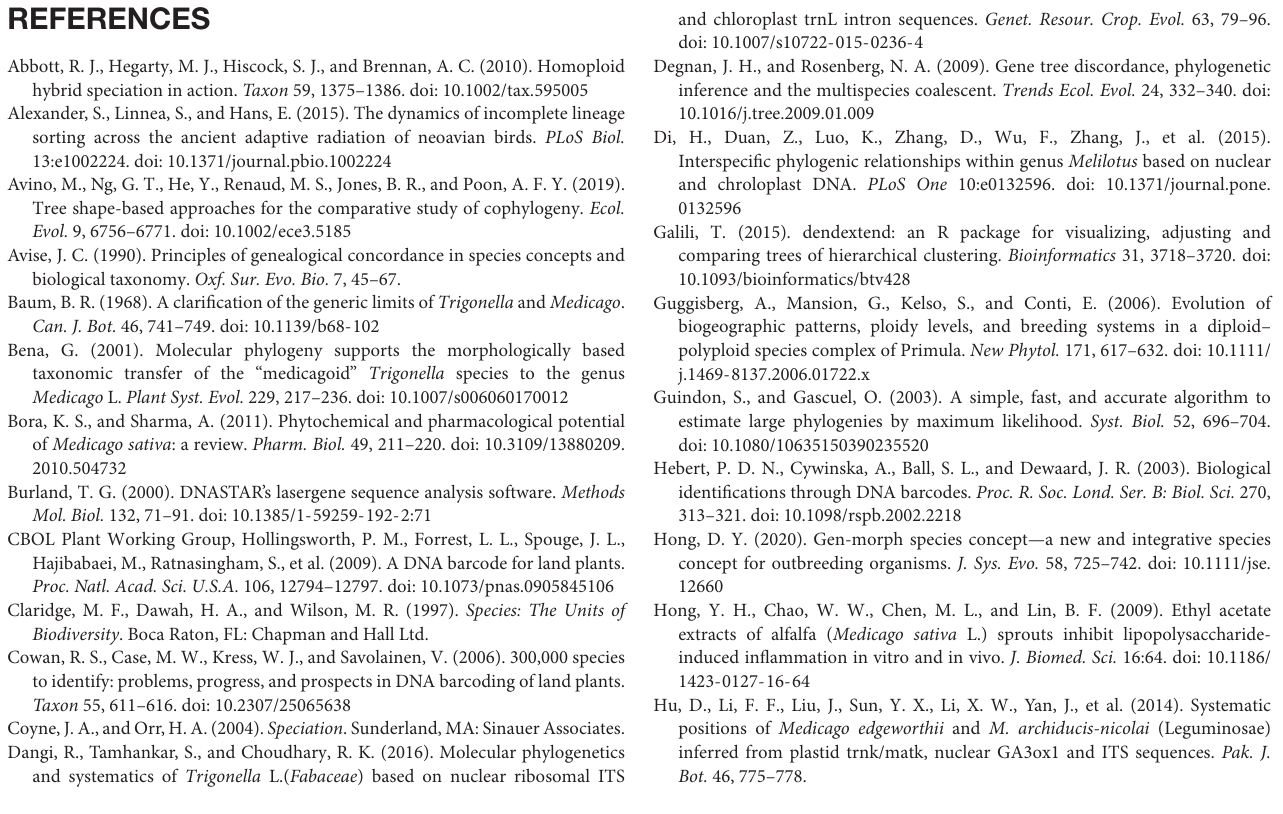
Supplementary Figure 2 | Phylogenetic tree based on the analyses of each of the four DNA markers for the sampled individuals showing the phylogenetic relationships of all the 21 species occurring in China. (A) GA3ox1 ; (B) ITS; (C) trnK-matK ; (D) psbA-trnH . Statistical support from maximum likelihood/Bayesian analyses are given above branches. The number in bracket indicate the number of individuals used for phylogenetic analyses. Supplementary Figure 3 | Morphological clustering of the four “ Medicagoid ” species, three Trigonella species and Medicago edgeworthii based on the principal component analysis. Colors are the same as in Figure 2 . Supplementary Table 1 | Locations of populations and number of individuals from each population used for the nrDNA and cpDNA phylogenetic analyses. Supplementary Table 2 | The primer pairs used in this study.